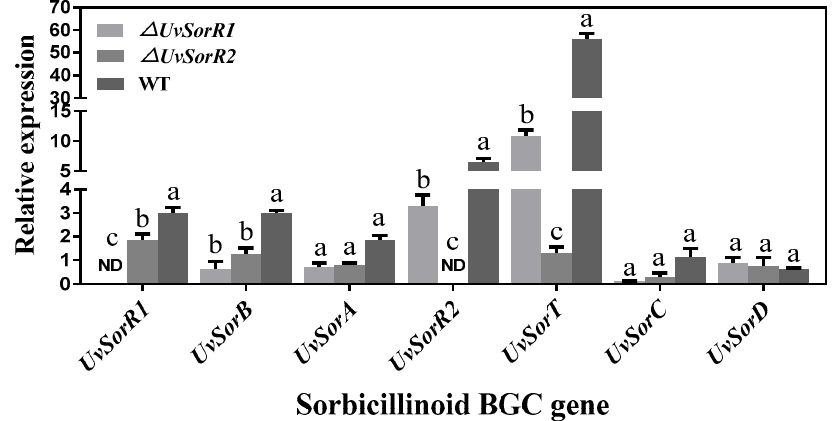
Figure 8. The relative transcript analysis of sorbicillinoid biosynthesis genes in the WT strain, as well as in ∆ UvSorR1 and ∆ UvSorR2 mutants. Different letters mean significant differences according to Duncan’s Multiple Range Test ( p < 0.05).